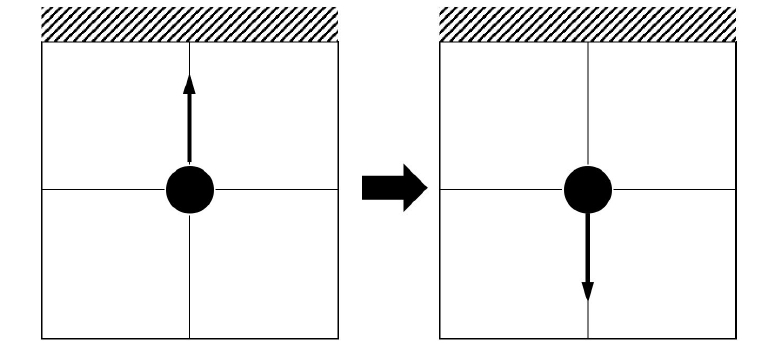
Figure 2. Schematic of bounce-back boundary condition.